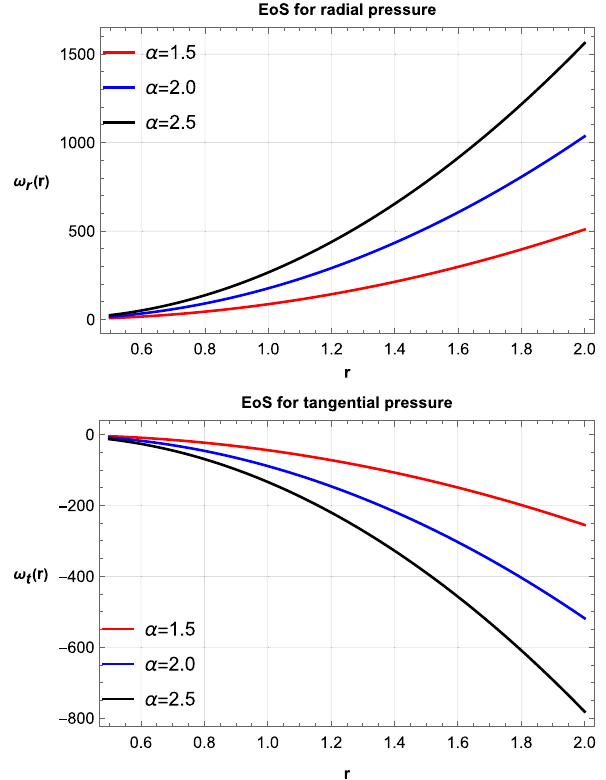
Fig. 6 The EoS parameter ω for parallel cylinder with r 0 = 0 .